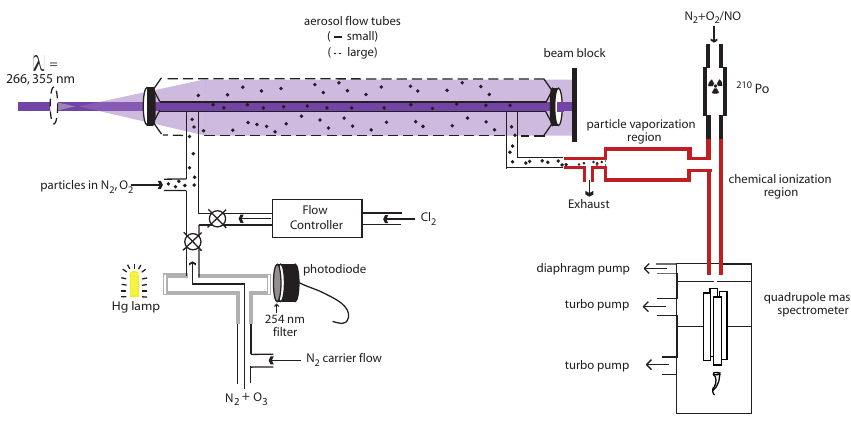
Fig. 1. Schematic diagram of the experimental setup to collect particle kinetic decays with: (1) fixed reaction time of 2s (small flow tube) or (2) variable reaction time up to 66s (large flow tube). The chemical ionization schemes used for particle and gas-phase reference detection are described in the